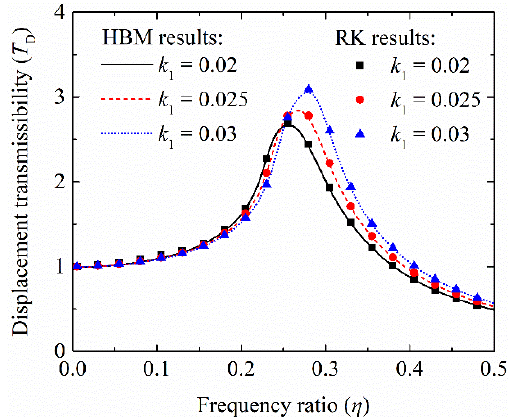
Figure 10. The frequency responses of the isolator with different values of k 1 .